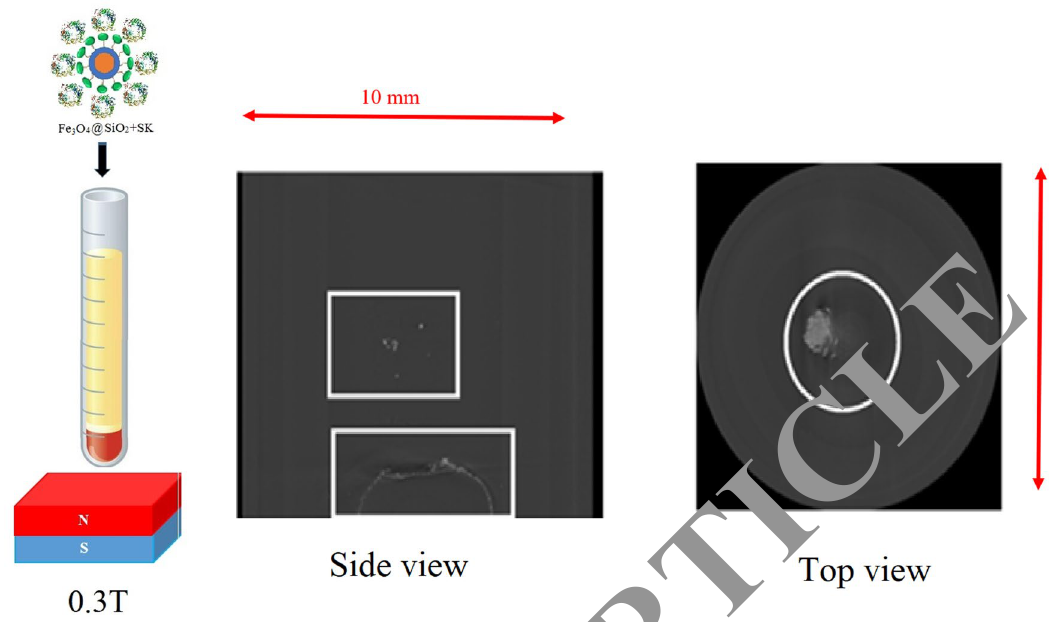
Figure 11. Micro CT-scan image clot under magnetic field 0.3 T. Schematic of applying magnetic field on clot and magnetic nanoparticles, side view and top view.